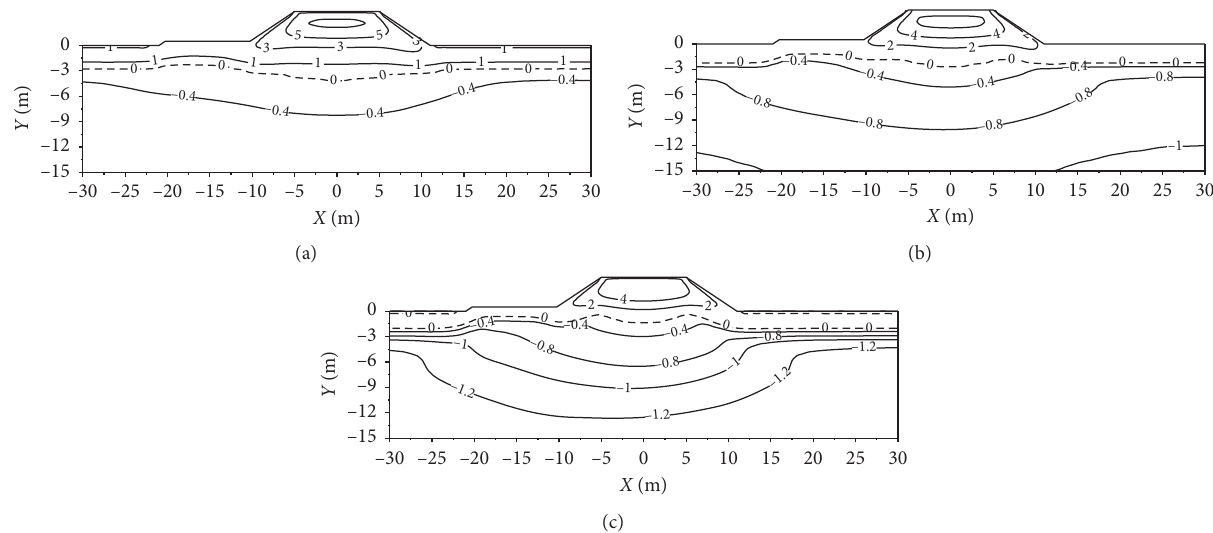
Figure 7: Distribution of the temperature field beneath the SE in October of the 20th year under the different mean annual ground temperatures: (a) − 0.5 ° C, (b) − 1.0 ° C, and (c) − 1.5 ° C (unit: °